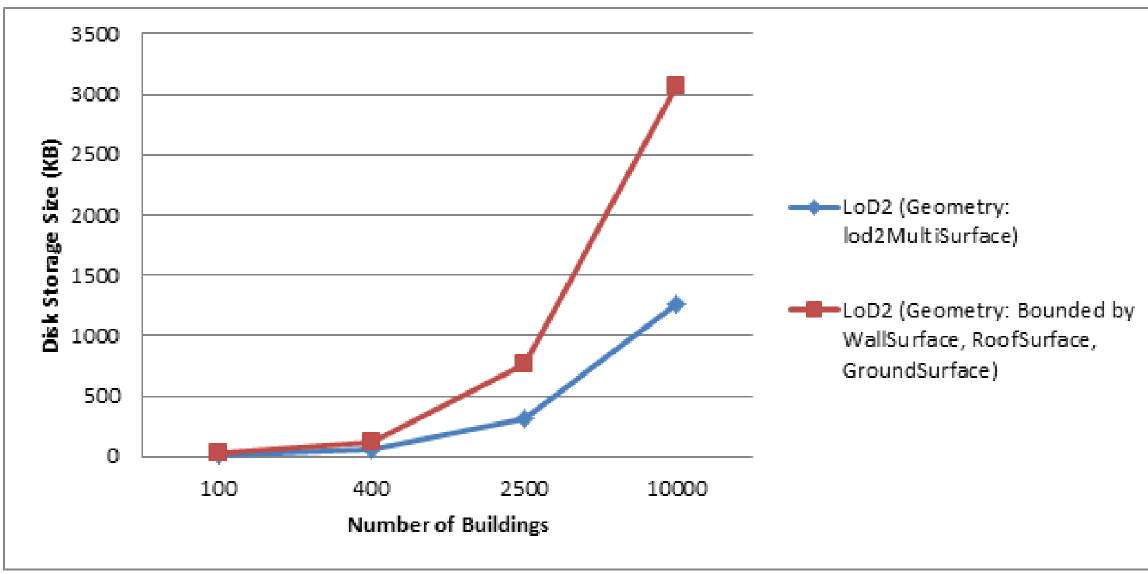
Figure 4: Disk storage comparison between two LoD2 categories